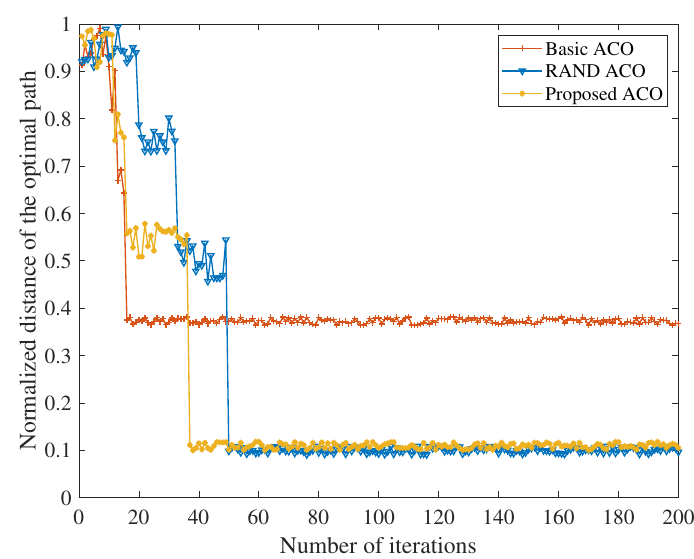
Figure 3. Comparison of convergence performance.